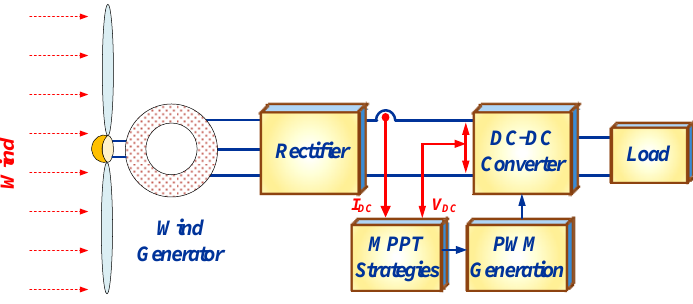
Figure 2. Proposed topology of maximum power point tracking (MPPT) and DC/DC converter. PWM: Pulse Width Modulation